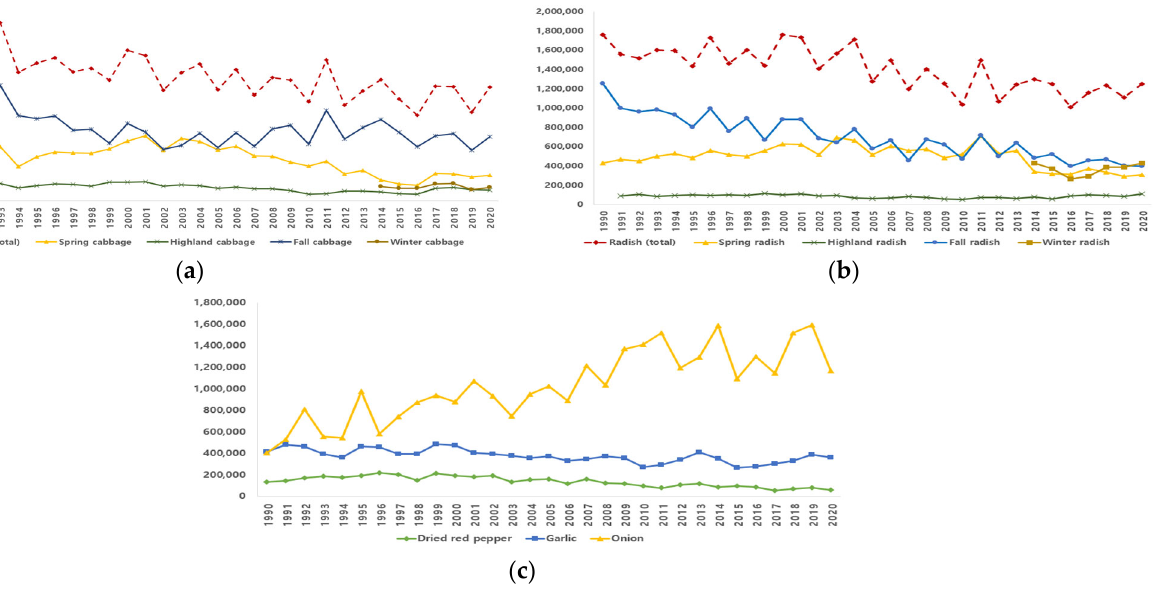
( d ) ( e ) Figure 1. Monthly Wholesale Prices of Major Vegetable Crops in South Korea (in KRW/kg). Source: KAMIS (Korea Agro ‐ Fisheries and Food Trade Corporation). ( a ) Cabbage; ( b ) Radish; ( c ) Dried Red Pepper; ( d ) Garlic; ( e ) Onion. Figure 2 shows the annual production of five major vegetable crops in South Korea from 1990 to 2020. We presented the detailed trends of yields for cabbage and radish with respect to the harvesting season. Cabbage is classified into four types: namely, Spring Cab ‐ bage (harvested between May and June), Highland Cabbage (harvested between July and October), Fall Cabbage (harvested between November and December), and Winter Cabbage (harvested between January and May). Radishes are divided into four types: Spring Radish